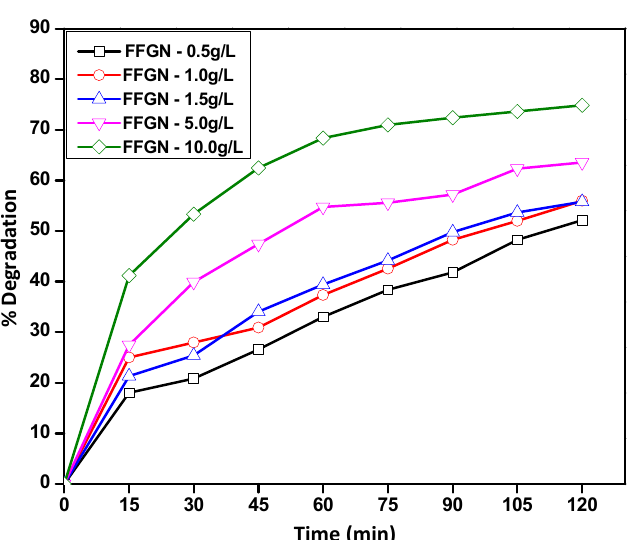
Figure 6. Degradation of ANB at different FFGN concentrations (pH = 3.0 ± 0.2, ANB = 50 ppm, NaIO 4 = 0.002 mol/L, Amplitude = 40%, Probe = 25 mm, T = 25 ± 1 °C) .